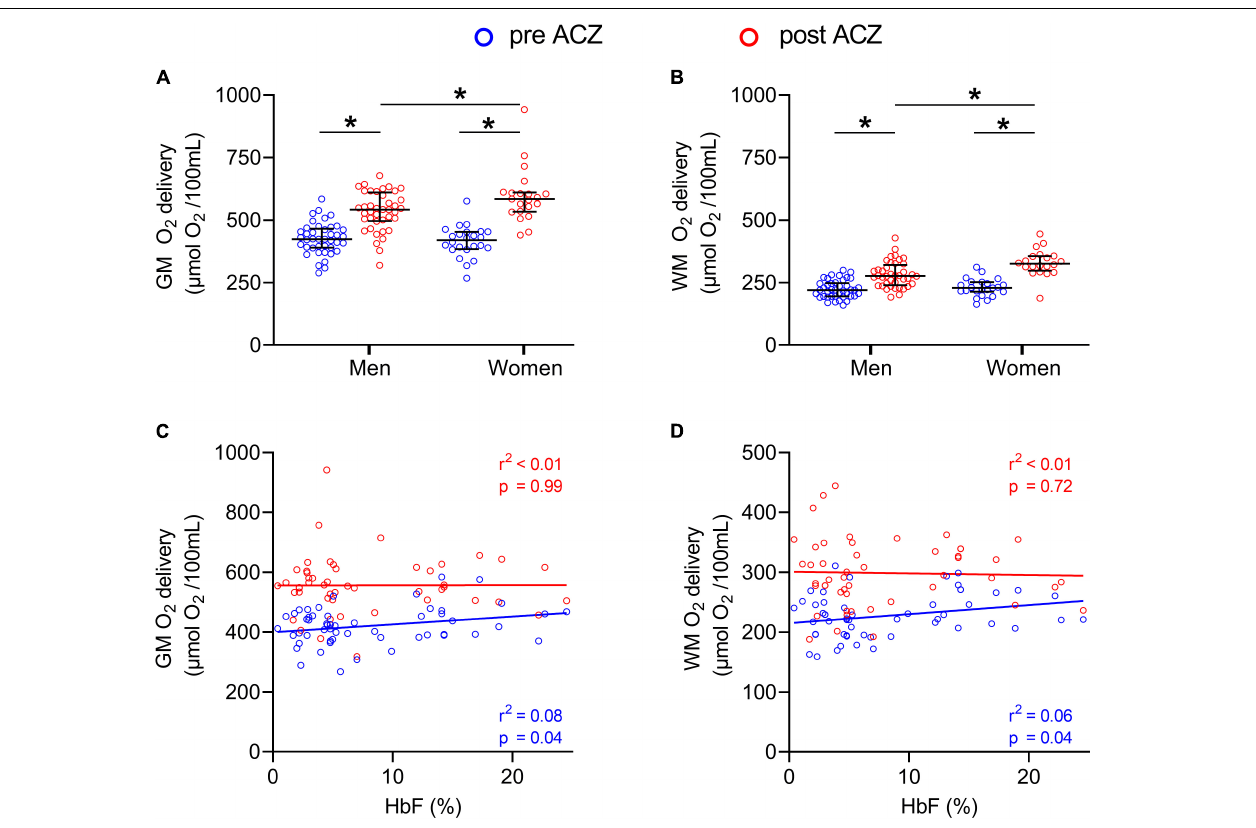
FIGURE 4 | GM and WM oxygen delivery before and after ACZ administration. Dot plots showing GM and WM oxygen delivery in men and women before and after ACZ administration (A,B) and scatter plots with correlations between HbF and GM and WM oxygen delivery in patients (C,D) . Error bars denote median and interquartile range, horizontal bars with asterisks denote statistically significant differences ( p <